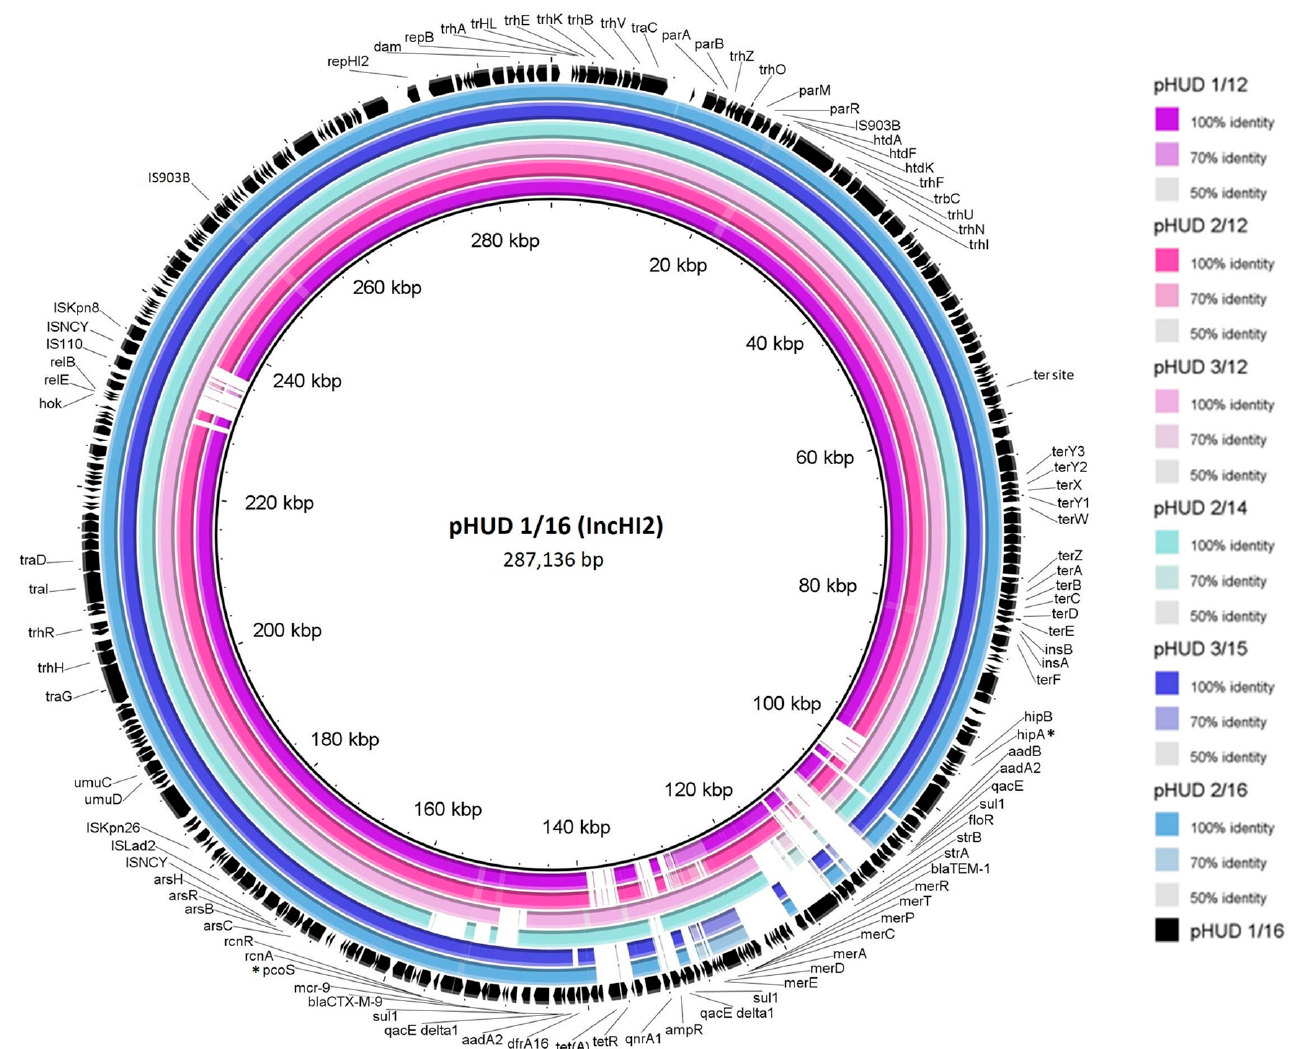
Figure 1. BRIG (Blast Ring Image Generator) comparison of bla CTX-M-9 -bearing IncHI2-ST1 plasmids found in monophasic S . Typhimurium ST34 isolates from a Spanish hospital. Each ring corresponds to a plasmid according to the color code specified on the right-hand side. pHUD 1/16 was entirely sequenced in this study and used as the reference (inner black ring). Relevant genes of this plasmid are displayed in the outer black ring, represented by arrows indicating the direction of transcription. Note that only the resistance genes are annotated for clarity in the large resistance region located between the hipA and pcoS genes (marked with an asterisk) (see Figure 2 for further details). To generate the image, the concatenated contigs of the other plasmids, as identified by PLACNETw, were used. Thus, the presence/absence of genes, but not necessarily the synteny, is accurate. Also, genes carried by these plasmids but absent in the control are excluded from the comparison but included in Figure 2.